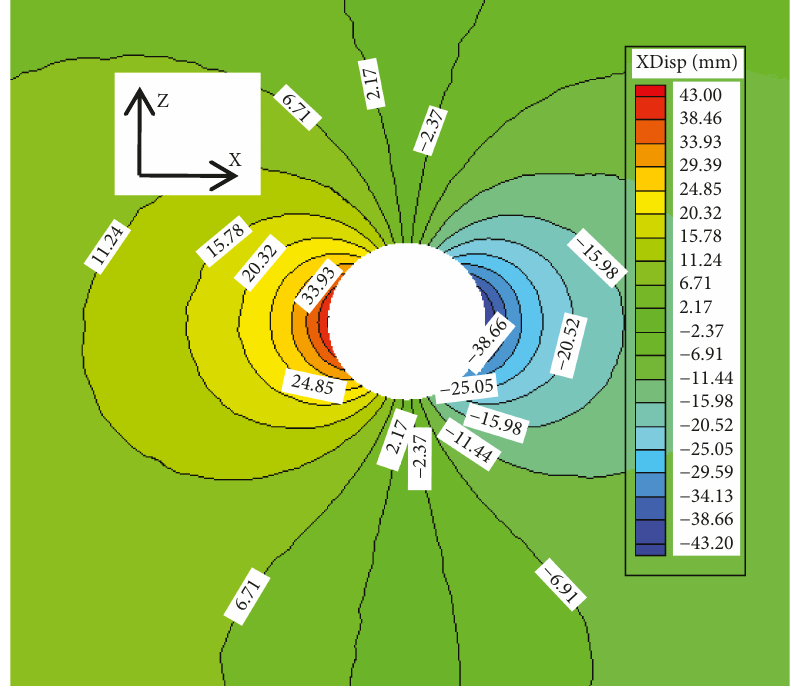
Figure 18: Displacement of section B-B along X.